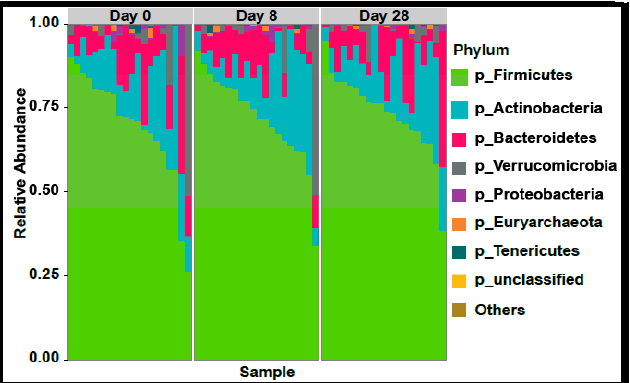
Figure 3. Plots showing the most abundant taxa at the phylum level as proportional abundances. in the three groups (Day 0, 8, 28). No significant differences were observed in any of the variables in the three time points evaluated (ANOVA for repeated measures).